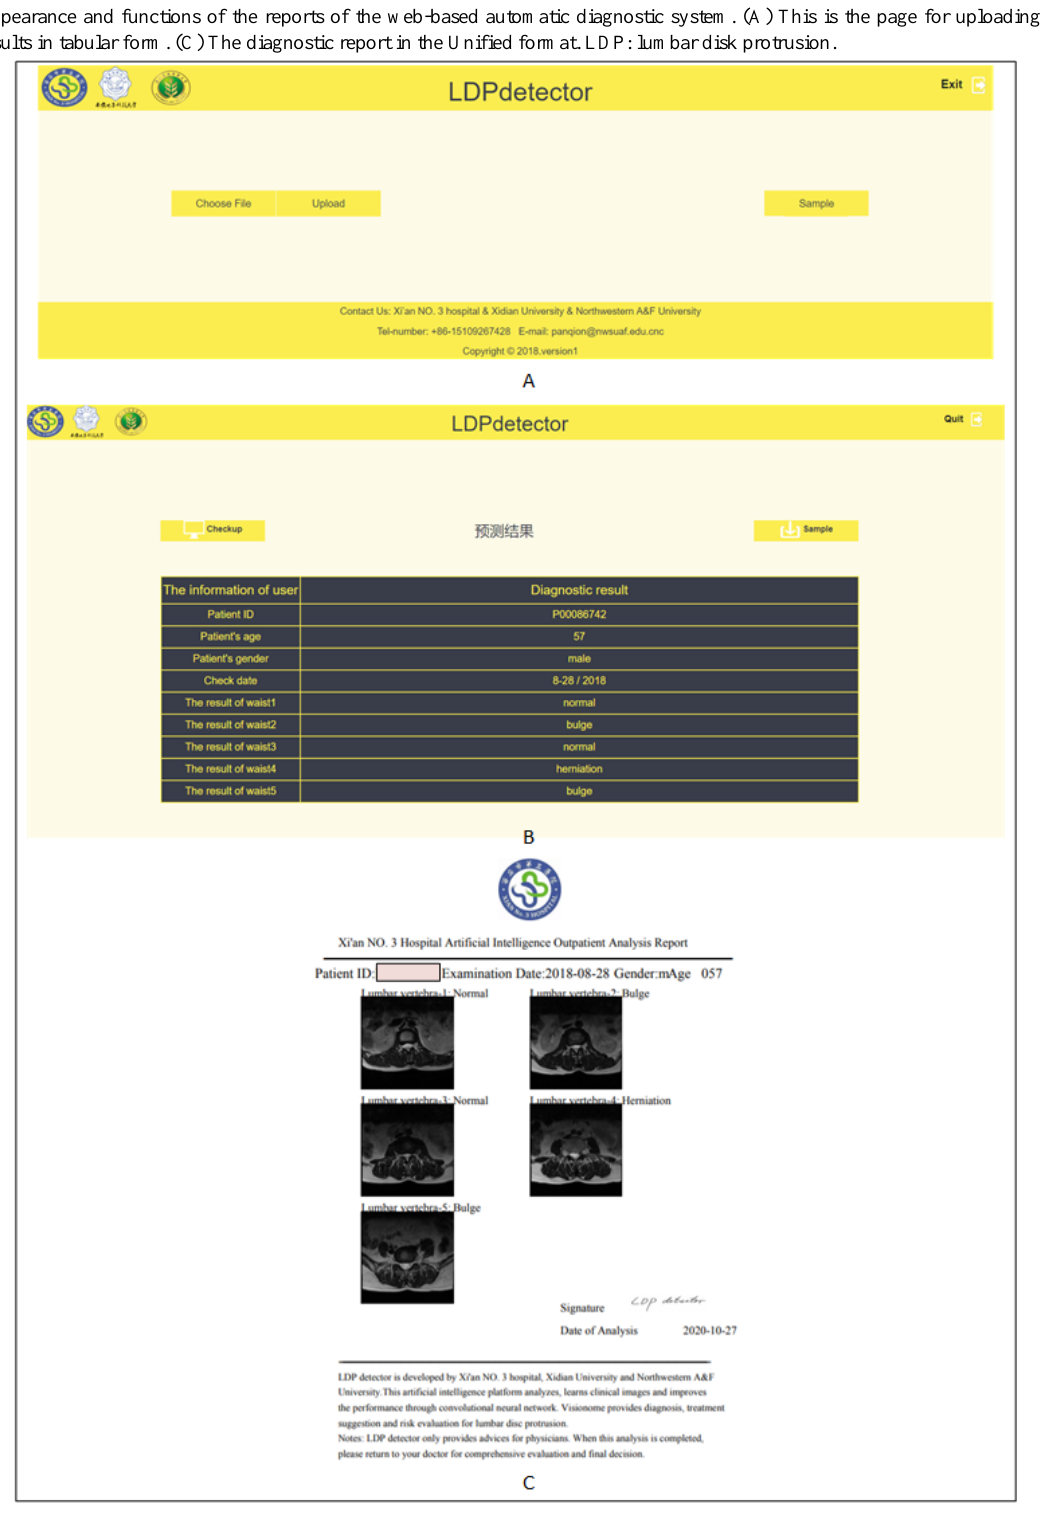
Figure 5. Appearance and functions of the reports of the web-based automatic diagnostic system. (A) This is the page for uploading a folder.